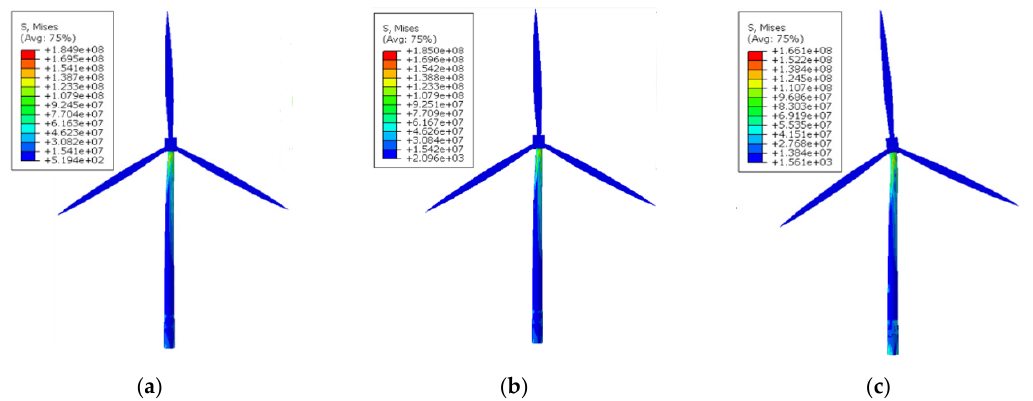
Figure 21. Structural stress cloud diagram: ( a ) two layer CFRP; ( b ) four layer CFRP; ( c ) eight layer CFRP.